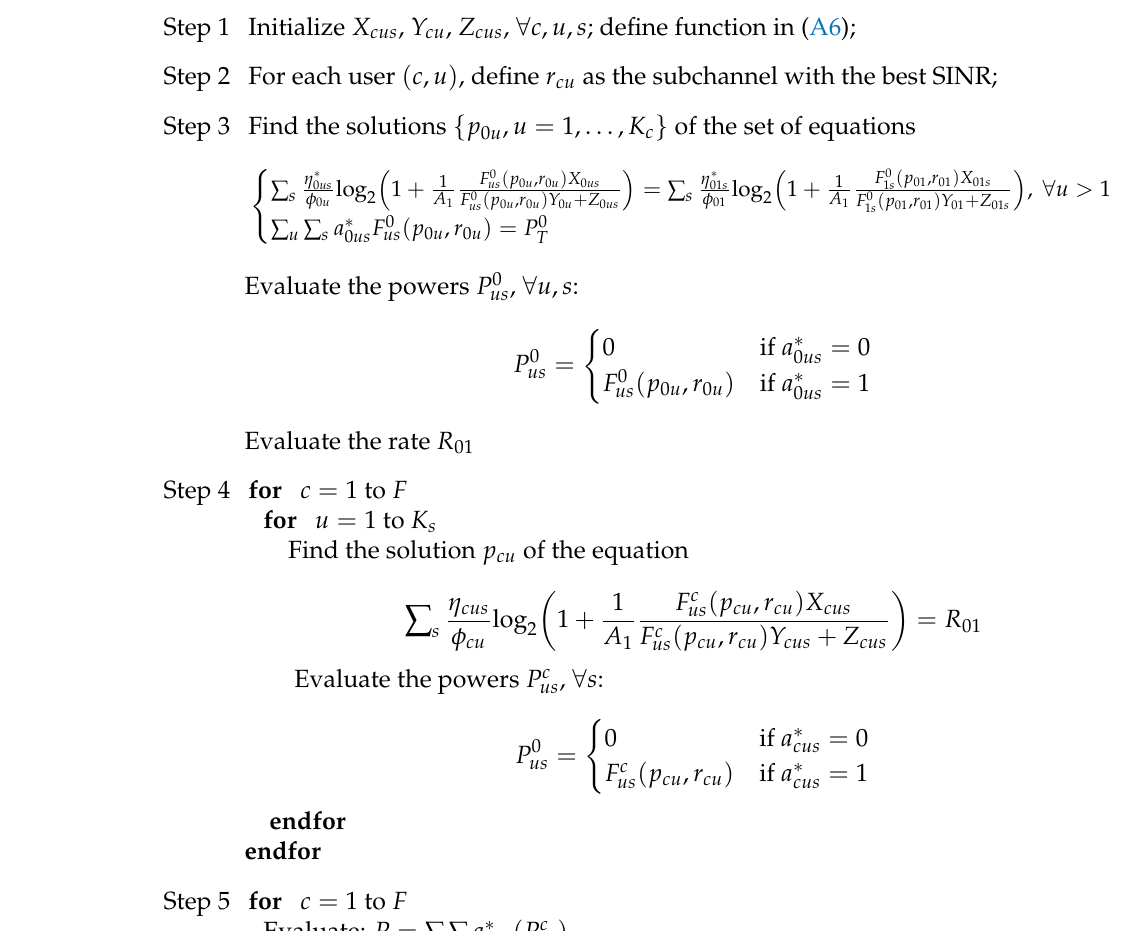
Algorithm 2 Power allocation